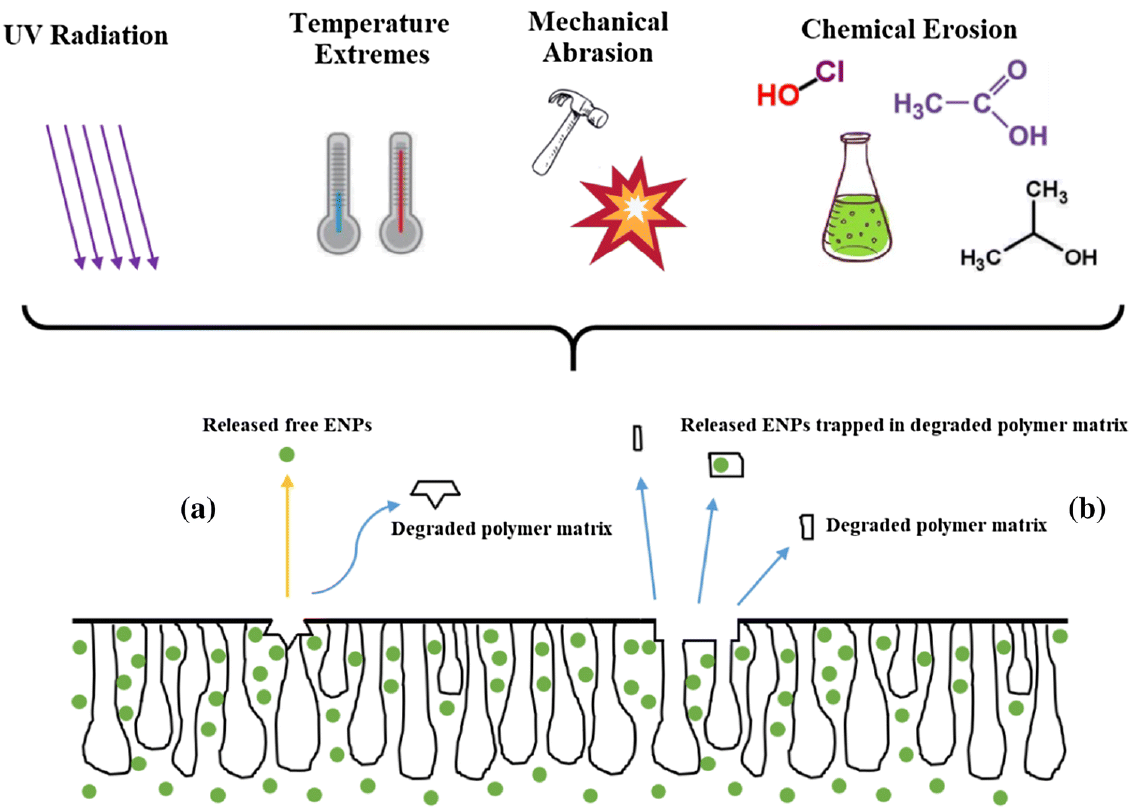
Figure 11. UV radiation, temperature extremes, mechanical abrasion, and chemical erosion as the four modes of polymer matrix deterioration. There are two ways that engineered nanoparticles (ENP) might release: either as ( a ) free particles when the polymer matrix degrades or as ( b ) particles combined with the destroyed polymer matrix.